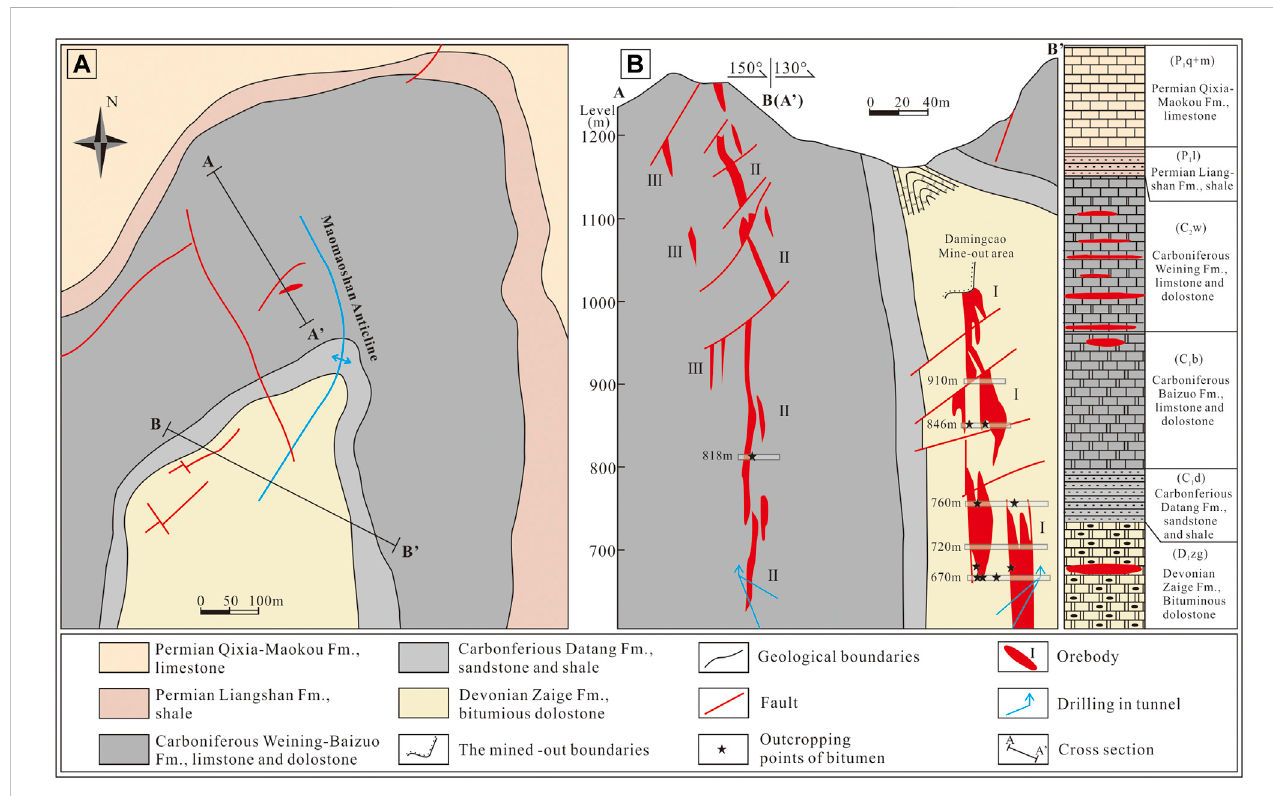
FIGURE 3 (A) Geological map of the Maoping deposit. (B) Cross-section through the Maoping Pb – Zn deposit (modi fi ed after Liu and Lin,